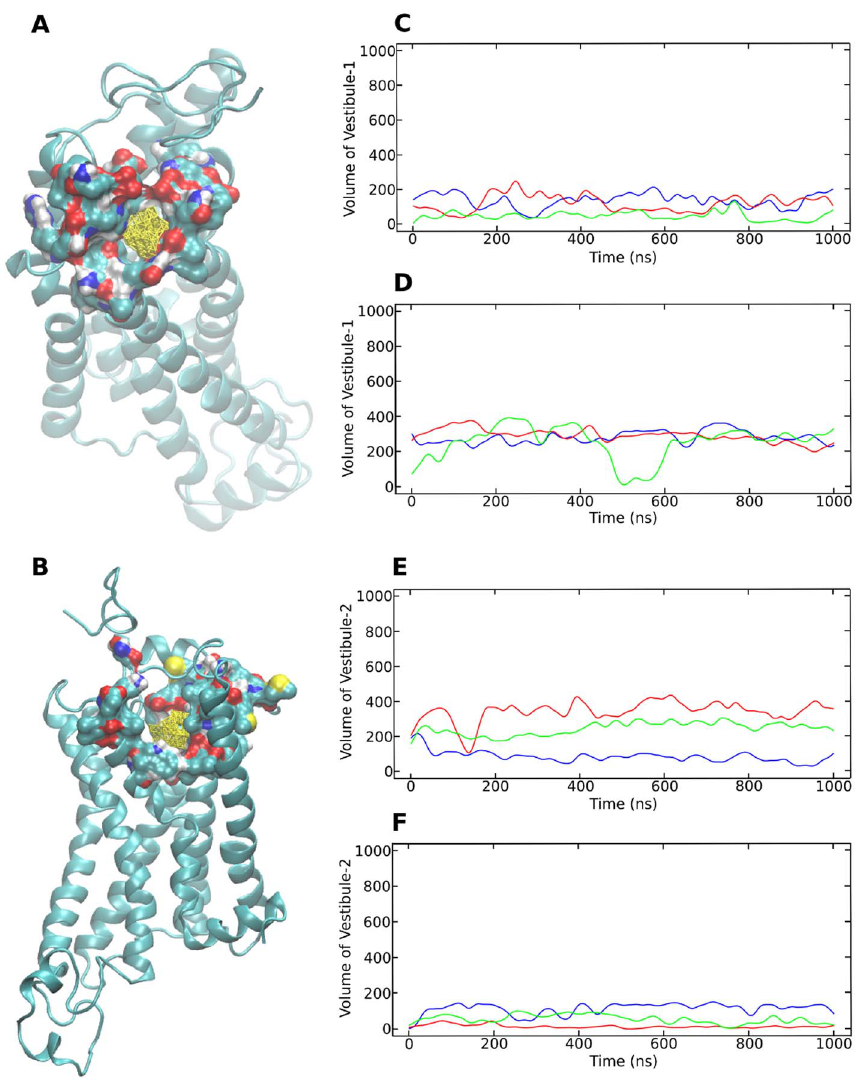
Fig. 6. Vestibules of ligand entry in b 2 AR variants. Grids representing vestibule openings for (A) vestibule1 and (B) vestibule 2 of b 2 AR are shown in yellow. Residues defining the vestibules are shown in surface representation while the rest of the receptor is rendered as ribbons and colored blue. Panel C and D represent volumes (in A˚ 3 ) of the non-occluded grid of vestibule 1 for the Arg and Gly variants, respectively. Panel E and F represent volumes (in A ˚ 3 ) of the non-occluded grid of vestibule 2 for the Arg and Gly variants, respectively. For each plot, the blue line indicates the first simulation, the red indicates the second and the green line indicates the third simulation.